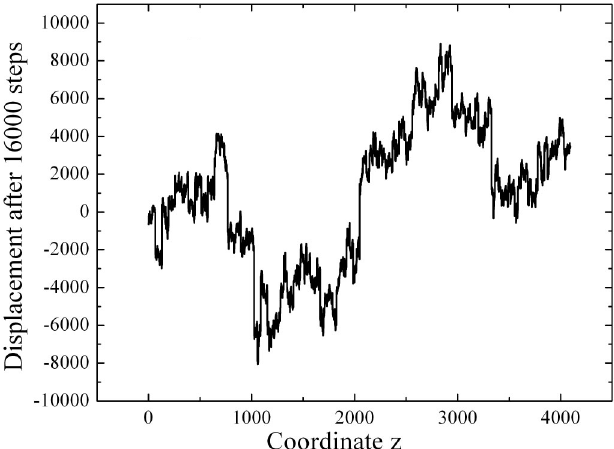
44. Fractal set of ground blocks (see